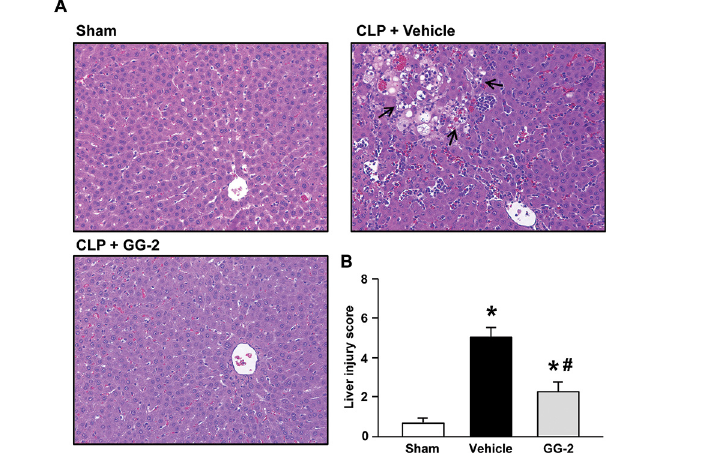
Figure 4. Effect of the combined treatment on the morphological structure of liver tissues in aged septic rats. Rats were sham operated or subjected to CLP with injection of vehi-